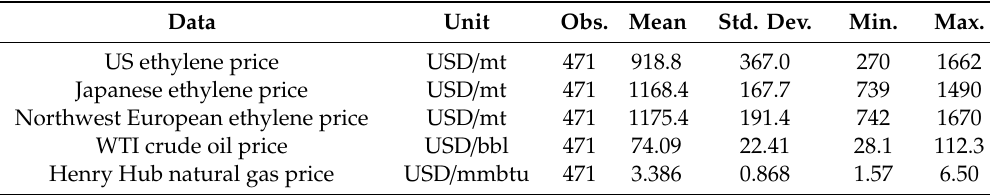
Table 1. Descriptive statistics. WTI—Western Texas Intermediate.